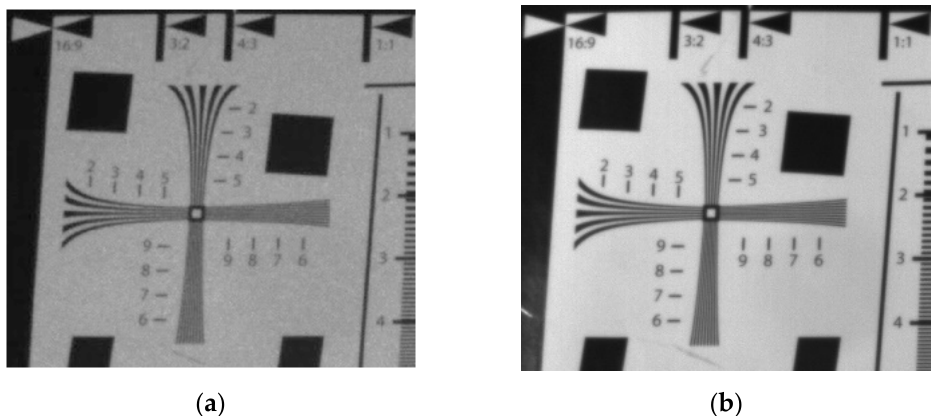
Figure 3. Comparison of several local magnification images (determination of visual resolution): ( a ) local magnification of original laser image with speckle noise; ( b ) local magnification of LED image without speckle noise.